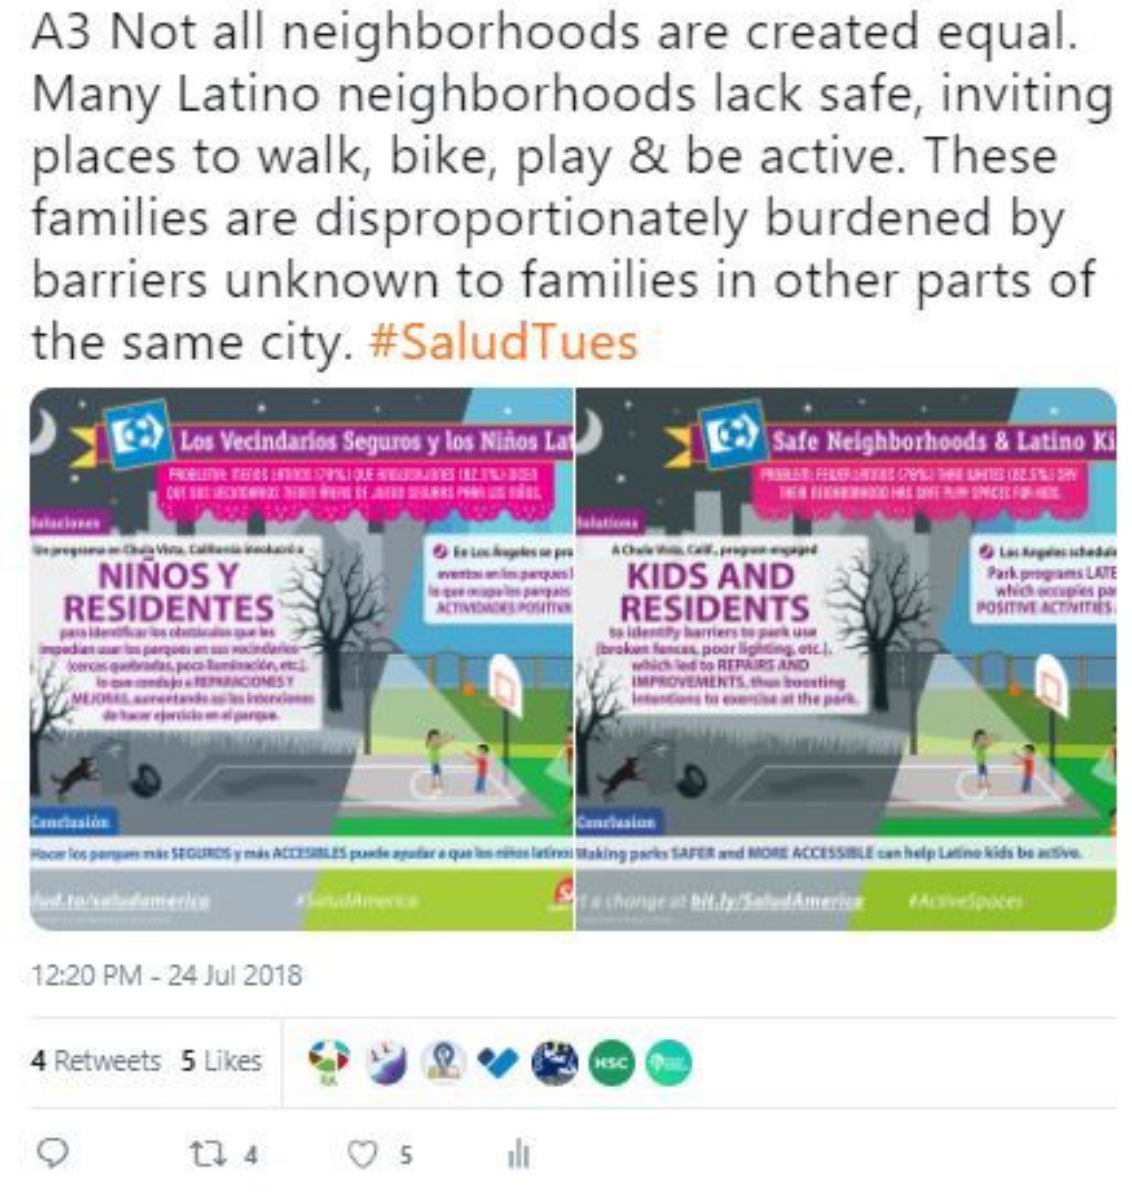
Figure 1. Example of a tweet during #SaludTues